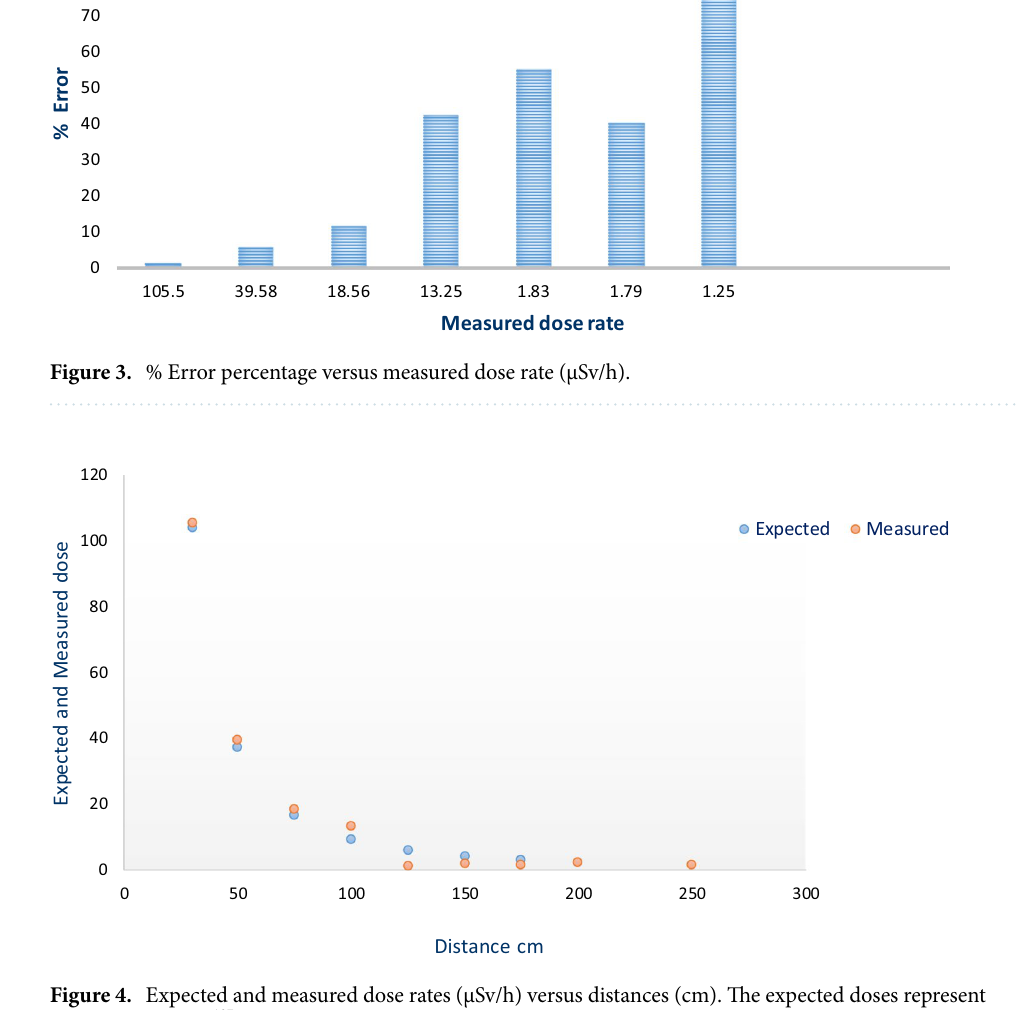
Figure 4. Expected and measured dose rates (µSv/h) versus distances (cm). The expected doses represent calibrated source ( 137 CS) values, whereas the measured doses represent the values recorded by the RadioactivityCounter